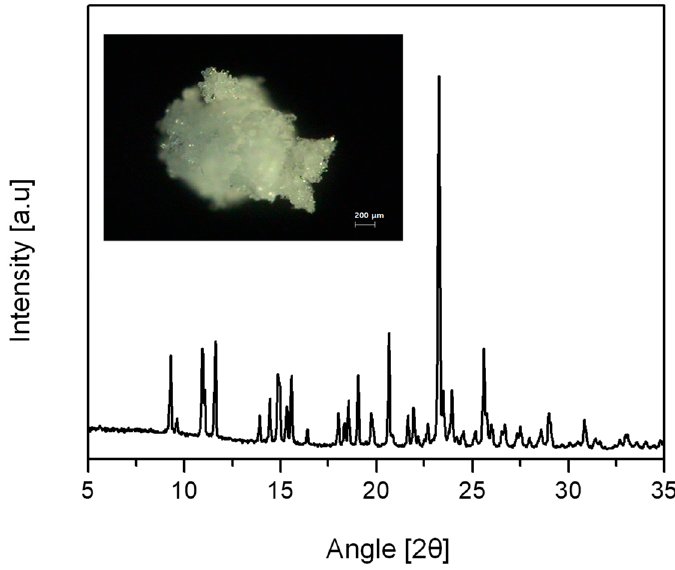
Figure 9. PXRD pattern and video microscope image of CLP crystals obtained at 35°C and IPA/Hex [v/v 40:60] antisolvent composition, without agitating the solution.